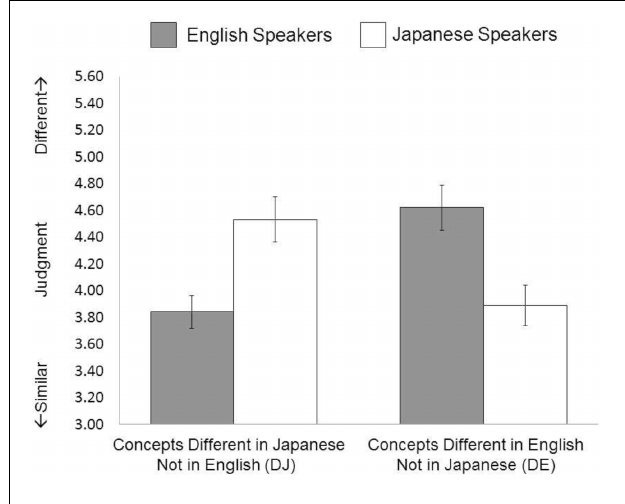
FIGURE 2 | Results of Study